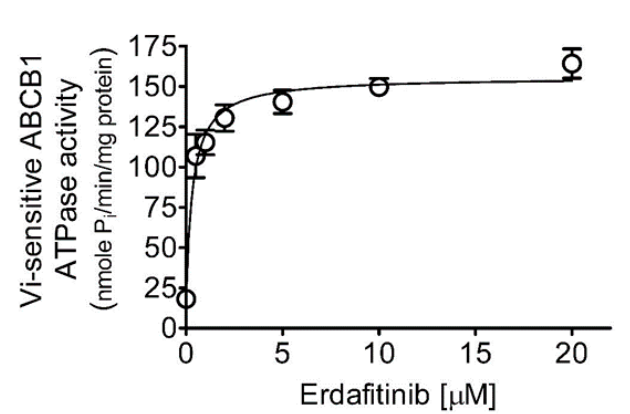
Figure 5. Erdafitinib stimulates ABCB1 ATPase activity. The effect of erdafitinib on vanadate-sensitive ATPase activity of ABCB1 was determined by the endpoint P i assay as described in the Materials and Methods. Data are presented as a mean ± S.D. from three independent experiments.